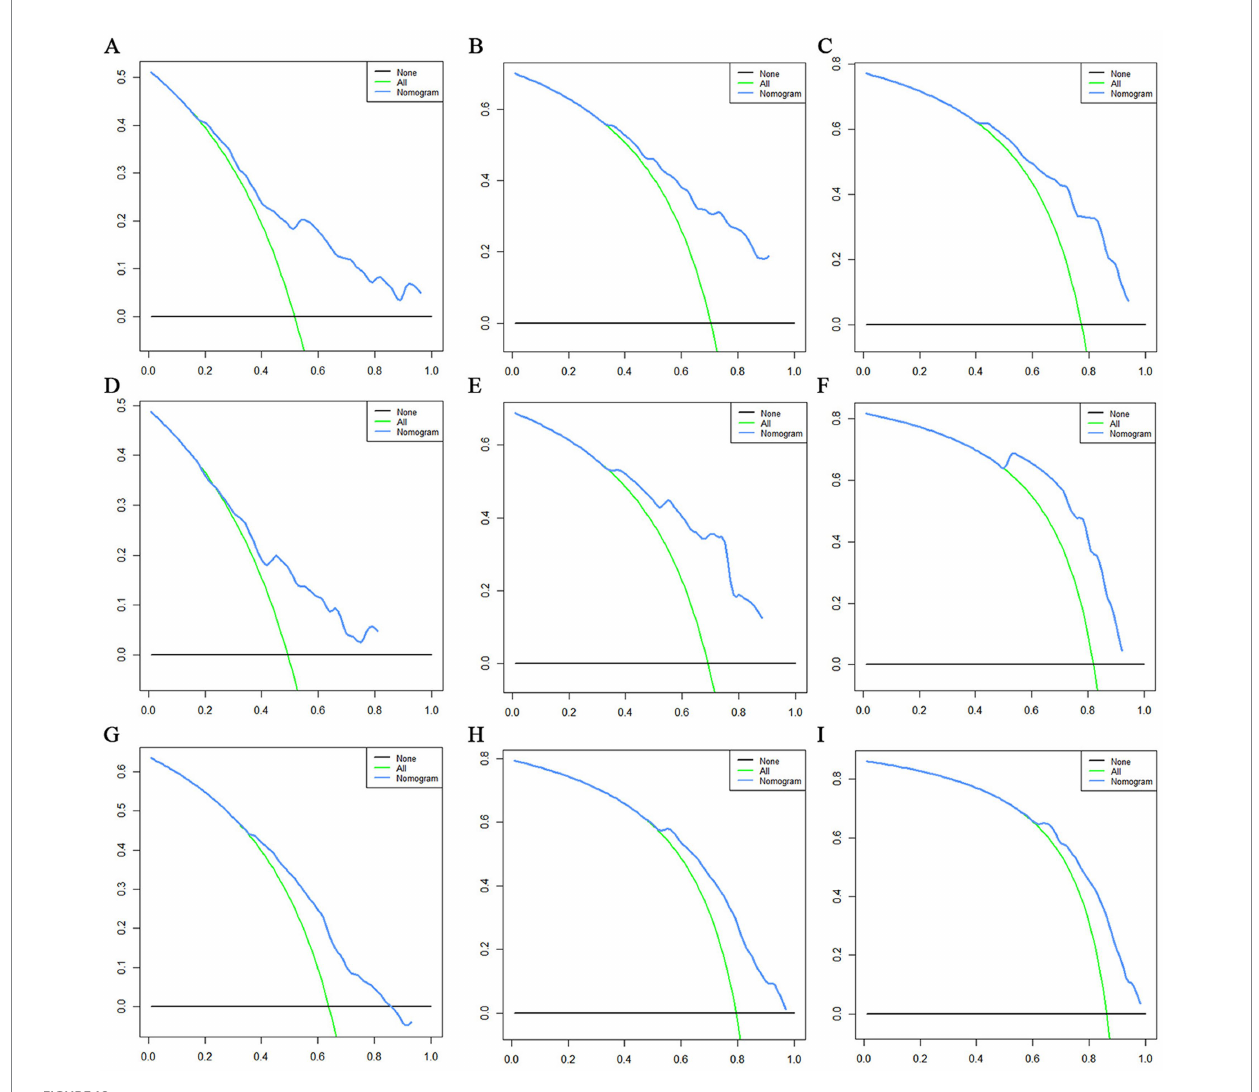
FIGURE 12 Decision curve analysis (DCA) curves for overall survival (OS) at 12 months (A) , 24 months (B) and 36 months (C) in the training set, DCA curves for OS at 12 months (D) , 24 months (E) and 36 months (F) in the validation set and DCA curves for OS at 12 months (G) , 24 months (H) and 36 months (I) in the extended validation